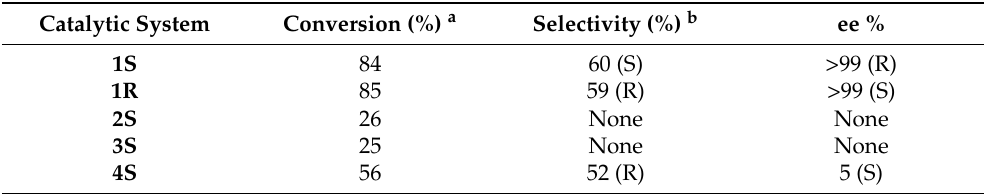
Figure 4. Linear peptoids used as catalysts. Table 2. Conversions, selectivities and enantiomeric excess for the catalytic oxidation of rac -1-phenylethanol by peptoids.